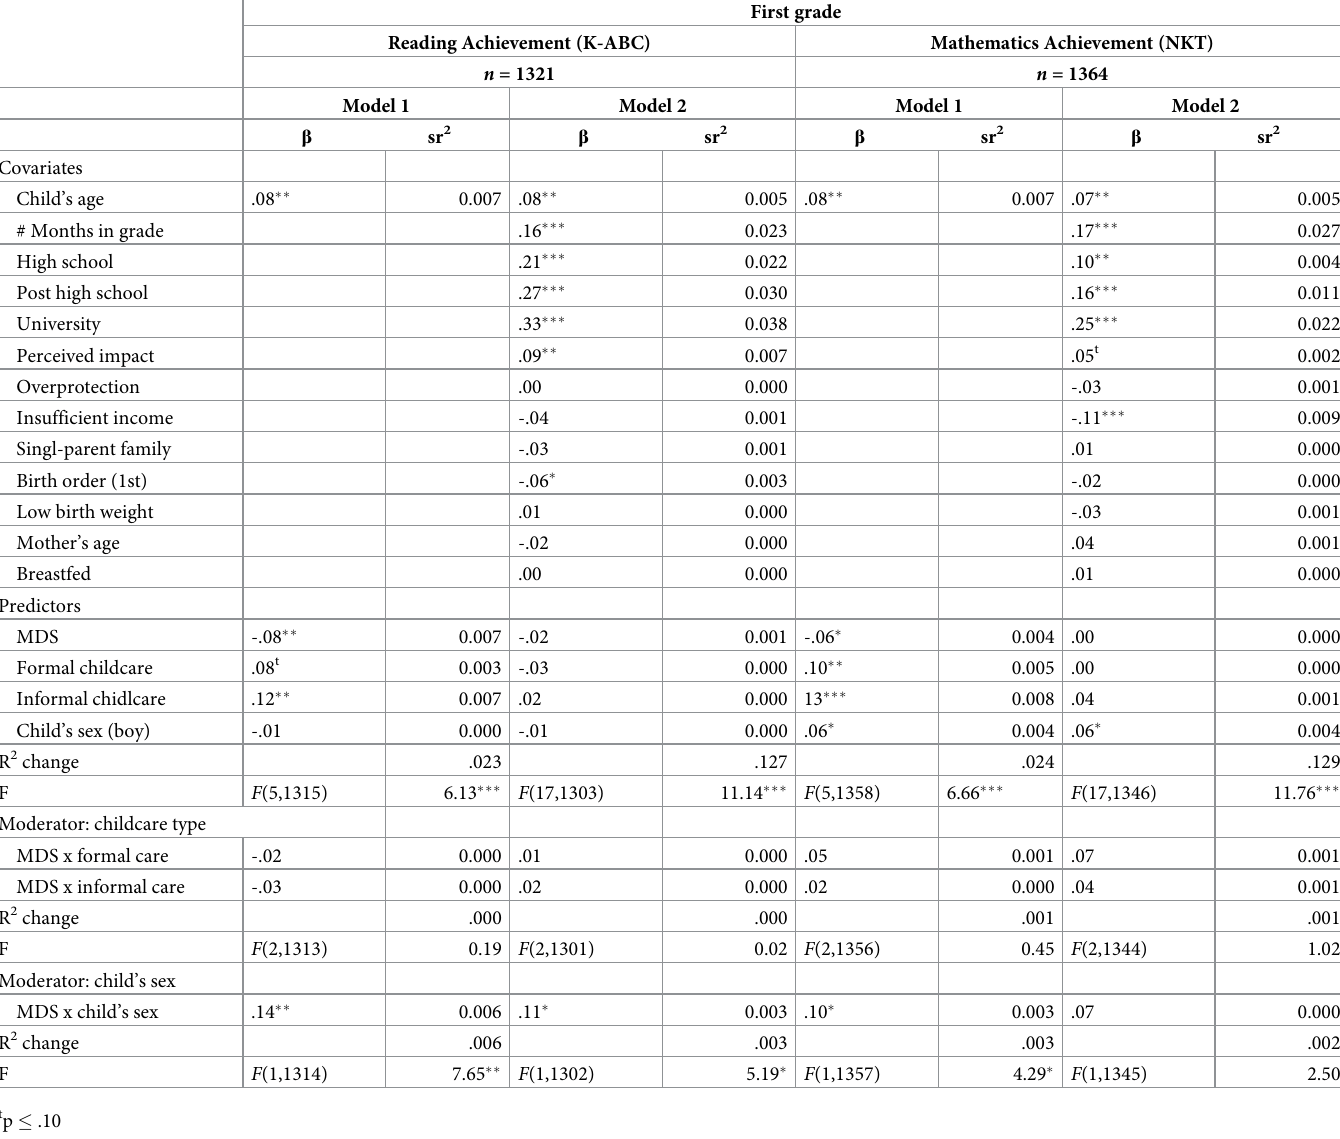
Table 3. Moderation analyses of MDS x Childcare type and MDS x child’s sex for first grade